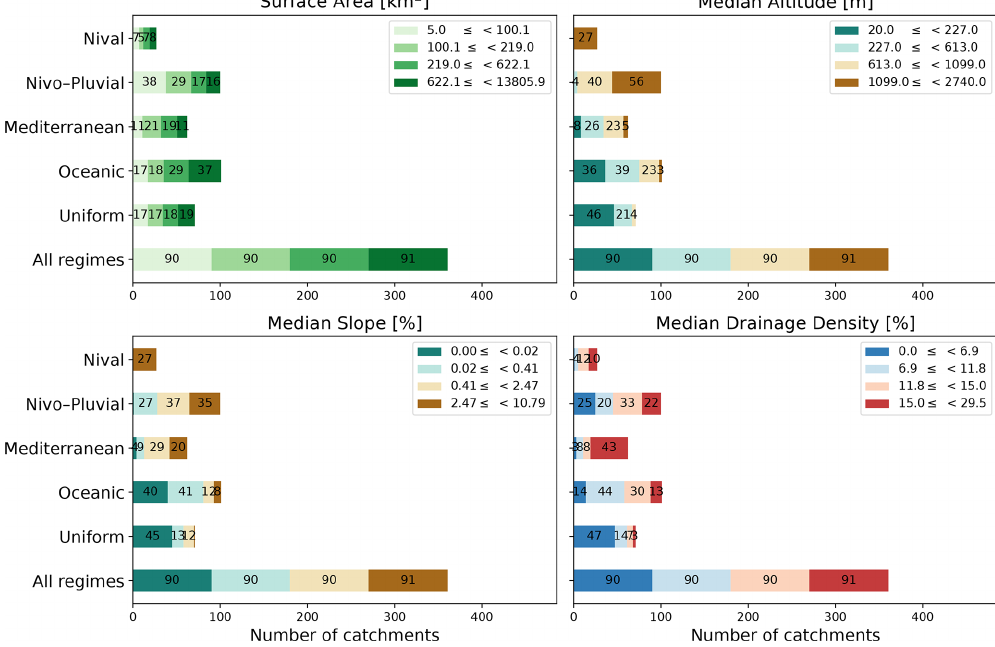
Figure 5. Stacked bar charts showing the variation in the four physical attributes used in this paper within each regime and the entire sample. The end-to-end segments of each bar correspond to the intervals for each quartile of the physical attribute of interest. The quartiles are computed by taking all 361 catchments into account. The number inside each segment denotes its